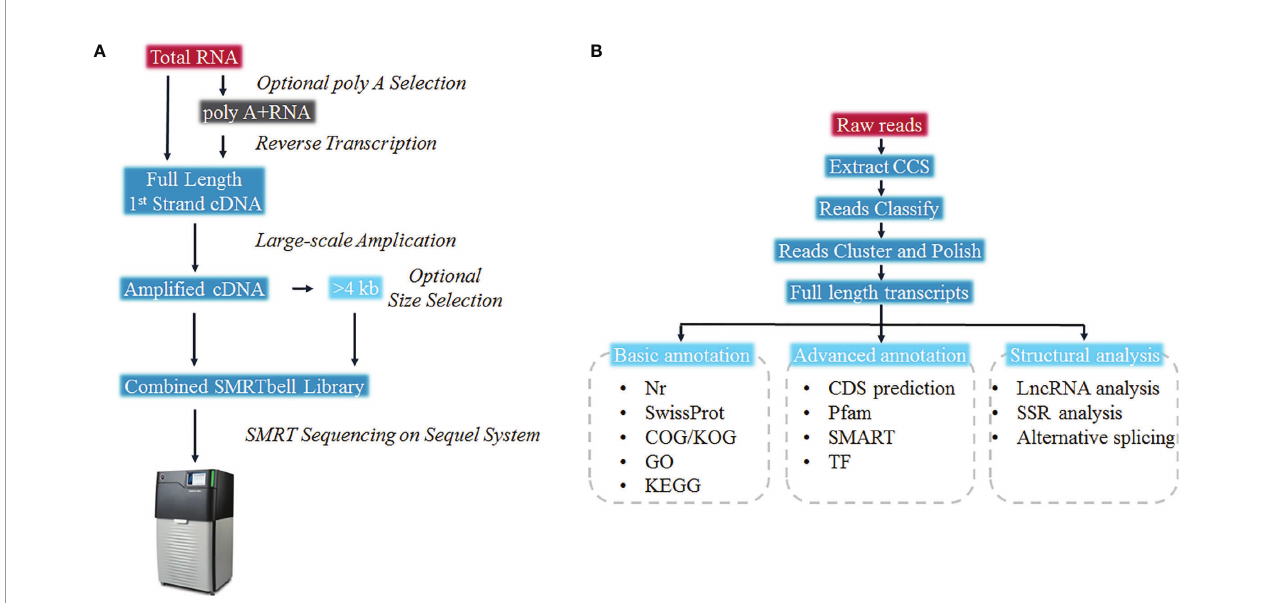
FIGURE 2 | Overall work fl ow diagram of (A) Sequel full length transcriptome cDNA library construction, and (B) full-length transcriptome data